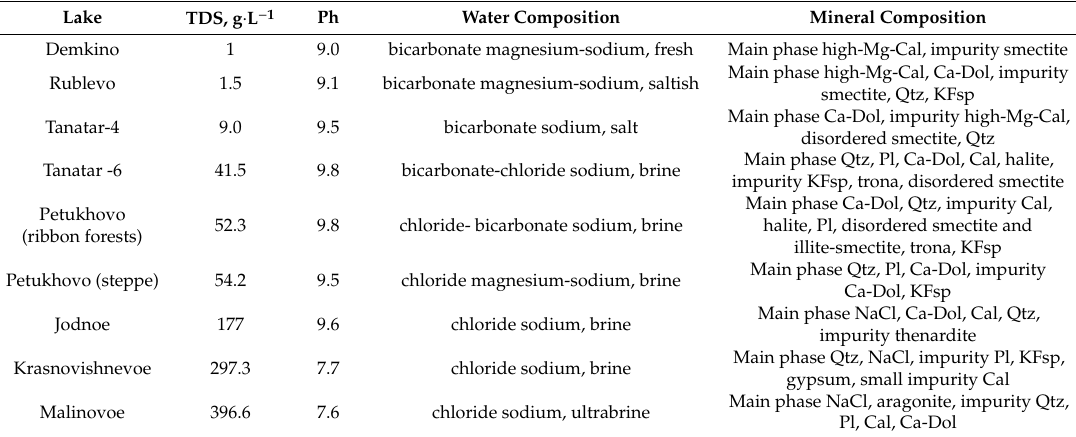
Table 2. Comparison of physical and chemical parameters and water composition of small lakes in the south of Western Siberia with the results of X-ray di ff ractometry (XRD).